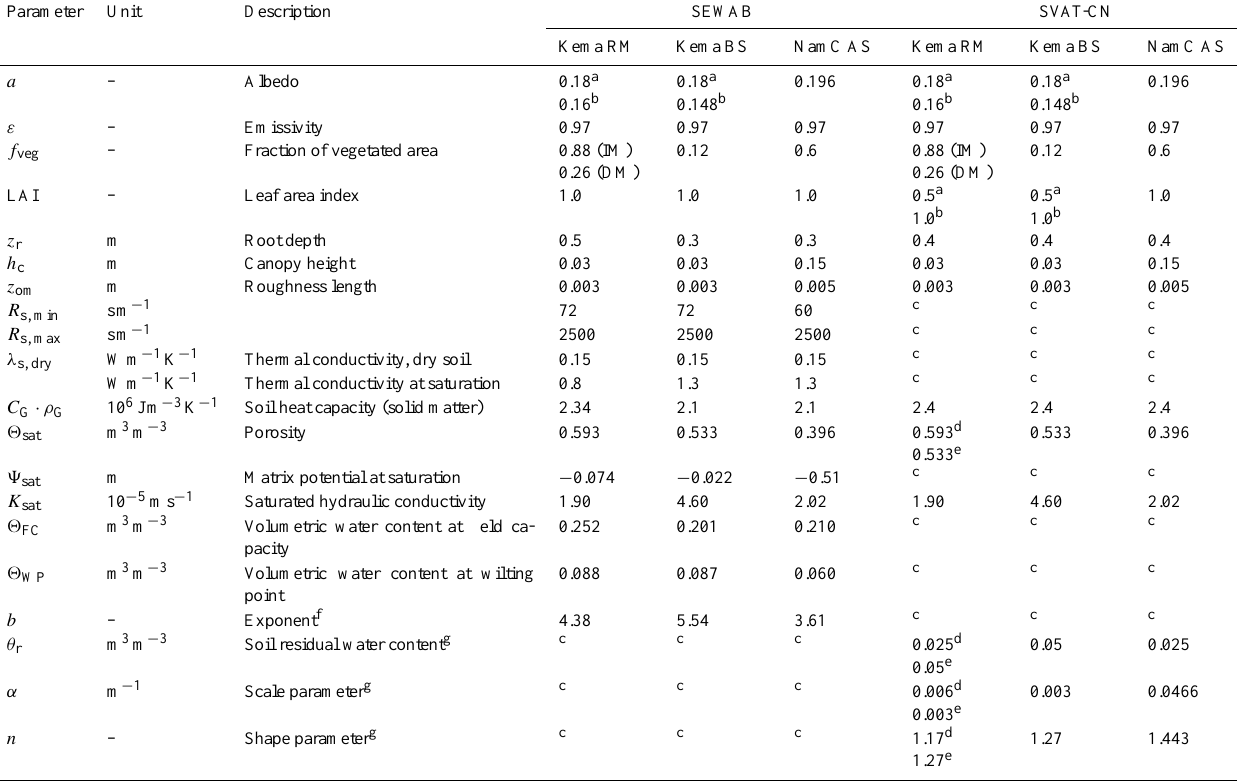
Table A1. Relevant parameters to describe the surface characteristic in SEWAB and SVAT-CN. Kema represents two parameter sets: (i) root mat (RM) for IM and DM; and (ii)